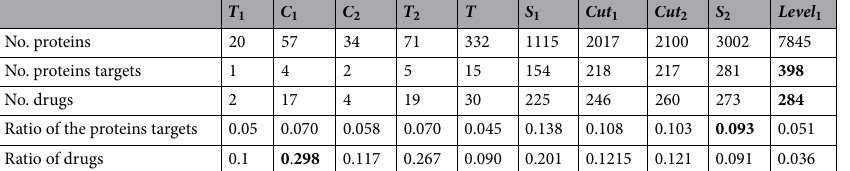
subset ( C ). It is noticeable that the P08684 protein is shown in red color, is one of the targets for most drugs in the Covid-Drug group. The red, blue, and black dotted edges are related to L , C , and T 2 sets, respectively.